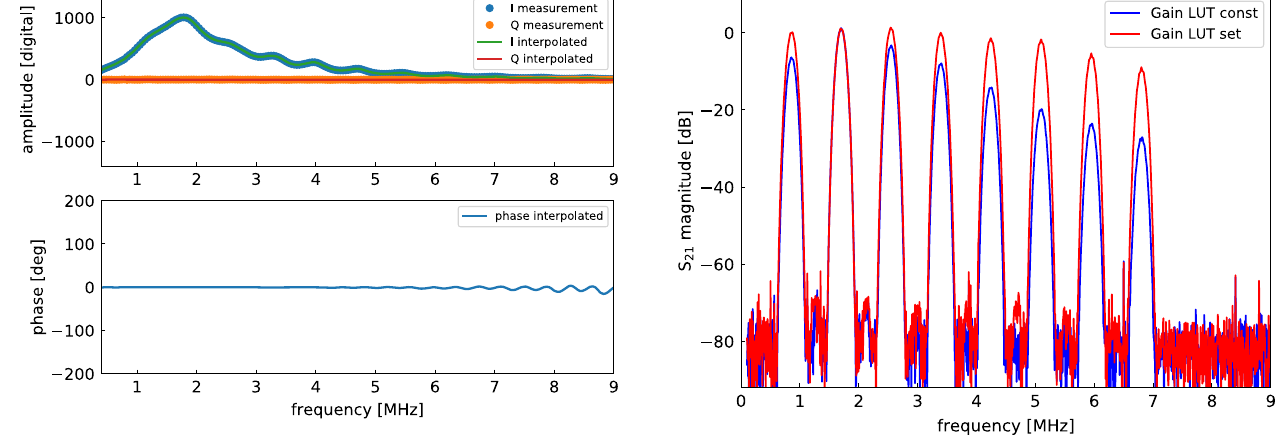
FIG. 18. Magnitudes of multiharmonic open loop transfer functions in the cases of the gain LUT const and set. The five-stage CIC filter is used in the feedback blocks for the